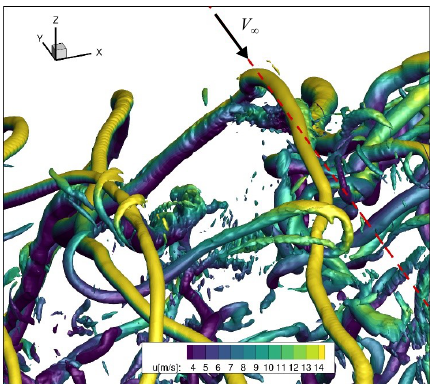
Figure 22. Visualization of the blade tip vortex helix at V W = 11.3m/s and ideal flight path (red dashed) at position 5 (CFD coordinate